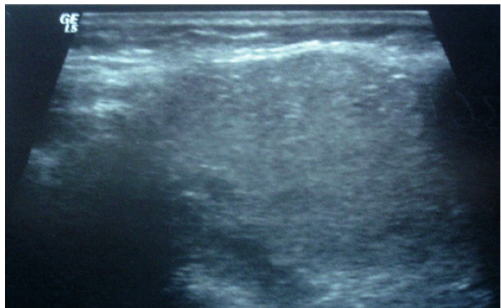
Figure 1: Ultrasonography findings; a 30 × 25 mm mass lesion with parenchymal echo pattern containing cystic degenerative areas in the left submandibular region.